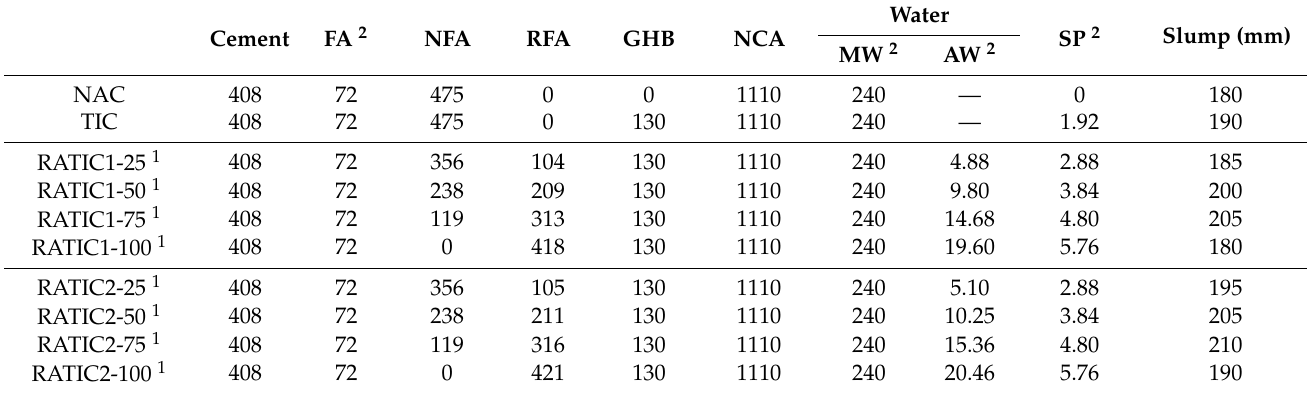
Table 5. Mix proportions of RATIC under different replacement ratio (kg).